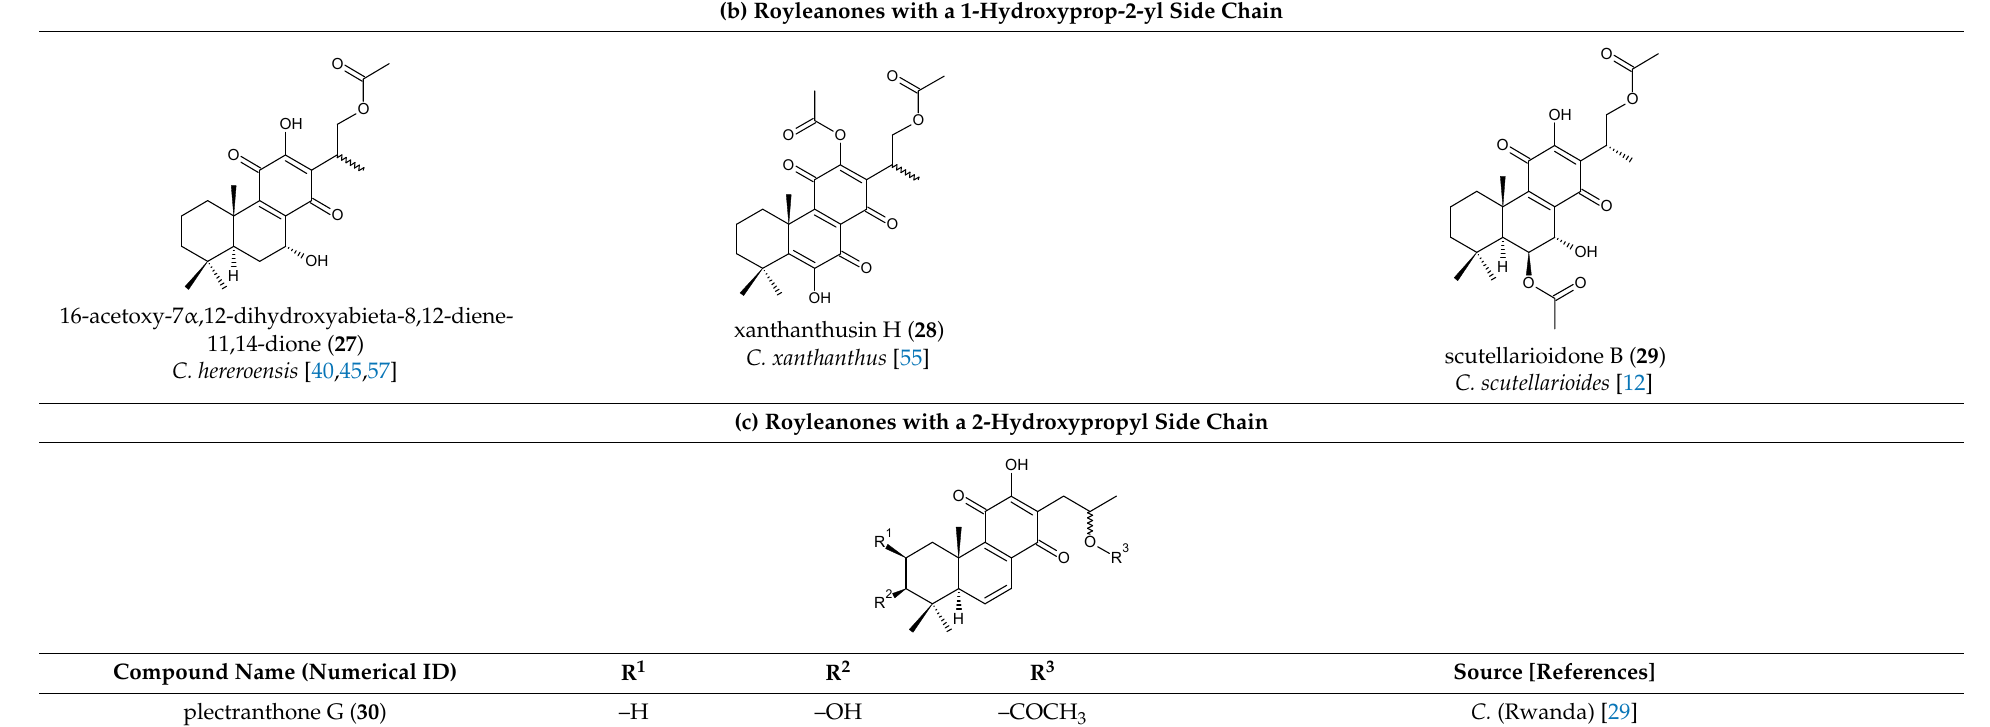
Table 1. Cont. (b) Royleanones with a 1-Hydroxyprop-2-yl Side Chain (b) Royleanones with a 1-Hydroxyprop-2-yl Side Chain (b) Royleanones with a 1-Hydroxyprop-2-yl Side Chain (b) Royleanones with a 1-Hydroxyprop-2-yl Side Chain